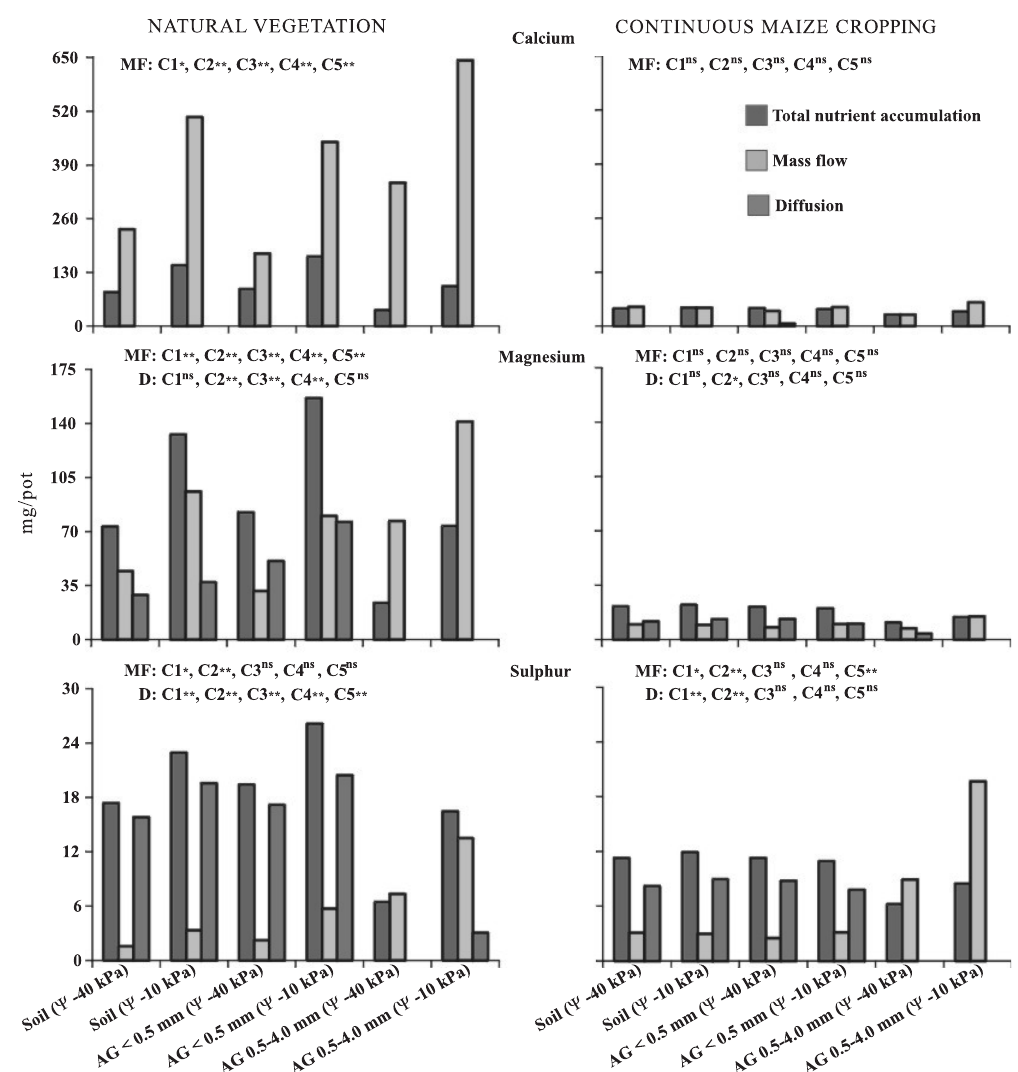
Figure 2. Total calcium, magnesium and sulphur accumulation in maize plants and quantities supplied by mass flow (MF) and diffusion (D), considering the material used for testing, soil or aggregates (AG), the water potential ( ΨΨΨΨΨ ) and the management system. Natural vegetation or continuous maize cropping. C soil vs. AG. C : AG < 0.5 mm vs. AG 0.5–4.0 mm. C : ΨΨΨΨΨ - 40 kPa vs. ΨΨΨΨΨ -10 kPa for soil. C 2 3 : ΨΨΨΨΨ - 40 kPa vs. ΨΨΨΨΨ -10 kPa for AG 0.5–4.0 mm. * and ** significant at 5 and 1%, 10 kPa for AG < 0.5 mm. C 5 respectively, by the F